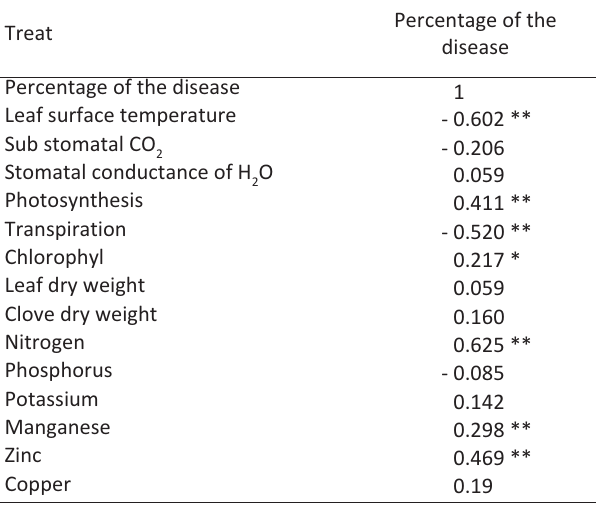
*, **, NS= significant at 5%, 1% and not significant probability levels, respectively.